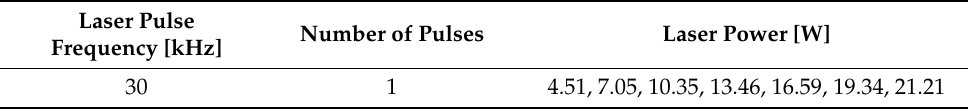
Table 6. Main parameters used in ablation threshold